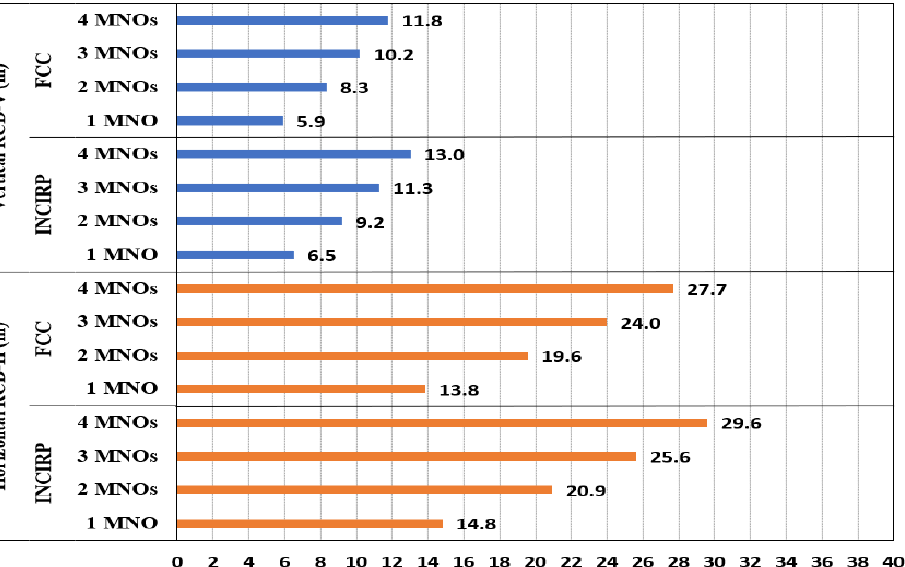
Figure 5. The R CD results for multi-technology multi-operator sharing a macro site, referencing the ICNIRP and FCC standards limits for GP.